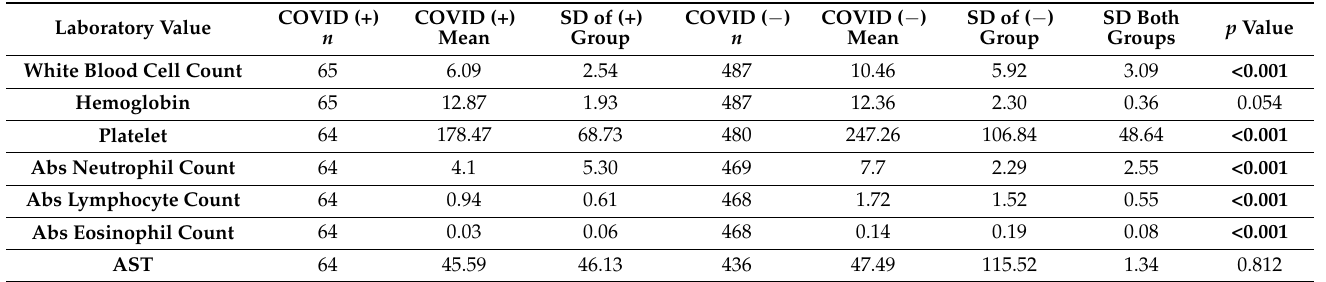
Table 1. Mean Difference of Laboratory Tests for